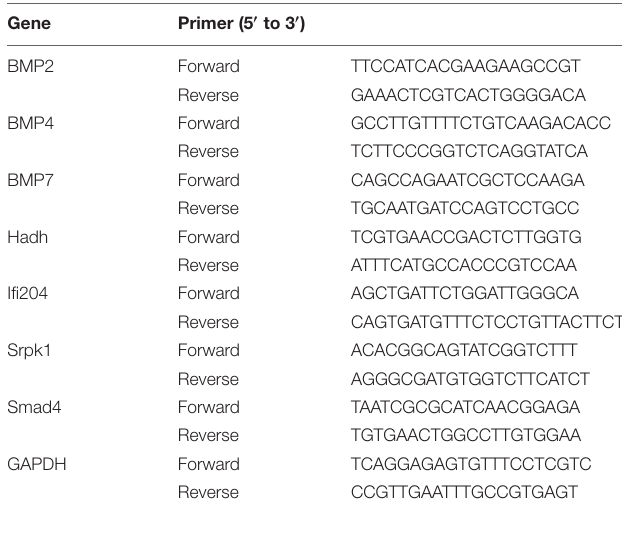
TABLE 1 | The primers of specific